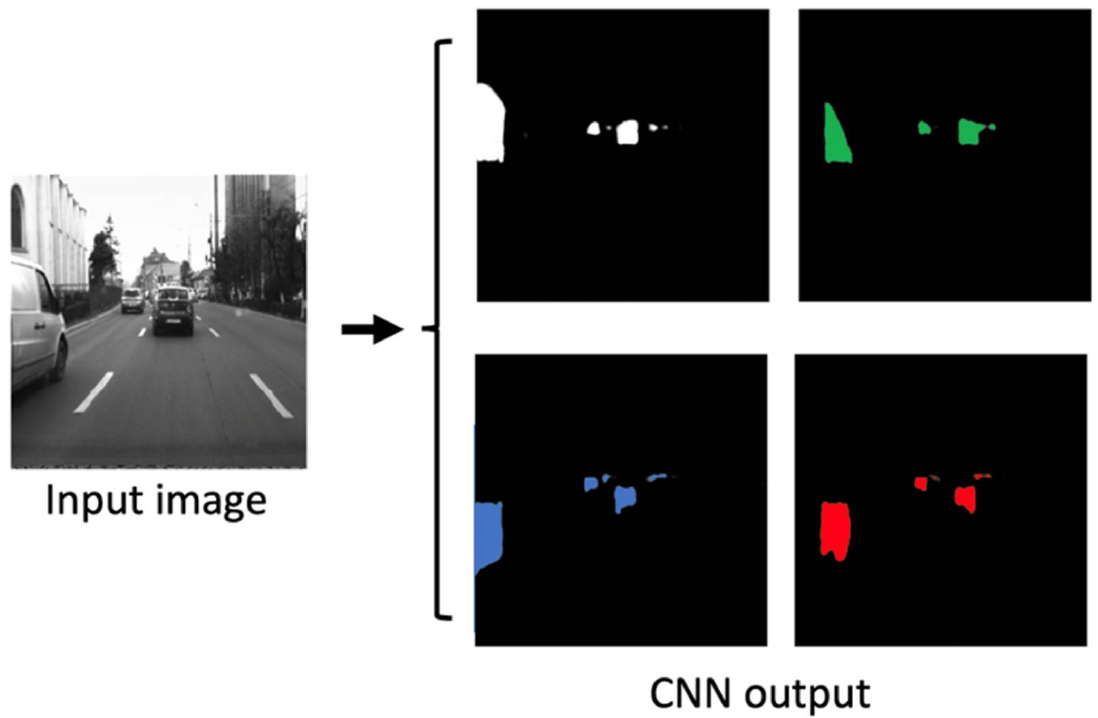
Figure 6. The artificial neural network, inferring the obstacle quarters.